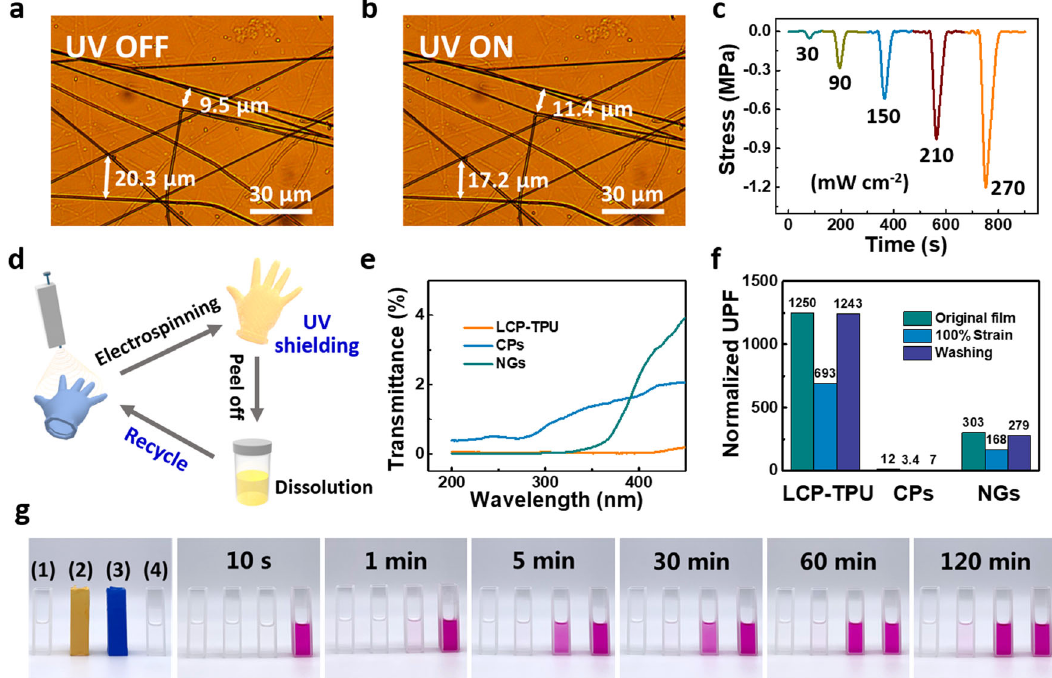
Fig. 3 Working mechanism and UV shielding ability. OM images of the ILCP fi ber networks a before and b after UV irradiation. c UV induced contraction stress curves in accordance with UV power density. d Schematic diagram of the conformal and recyclable UV shielding LCP fabrics. e Transmittance spectra of the LCP-TPU fabrics, commercial products (CPs), and nitrile gloves (NGs), respectively. f The normalized UPF of original samples, 100% strain stretched samples and water washed samples, respectively. The normalized UPF is de fi ned as the ratio of UPF over the fi lm thickness. g Photographs of the UV shielding property evaluation upon 20 mW cm − 2 UV light by photochromic spiropyran indicator (10 − 5 mol/L, ethanol solution). The four samples are (1) blank group, (2) LCP shielding group, (3) nitrile shielding group, and (4) no shielding group,